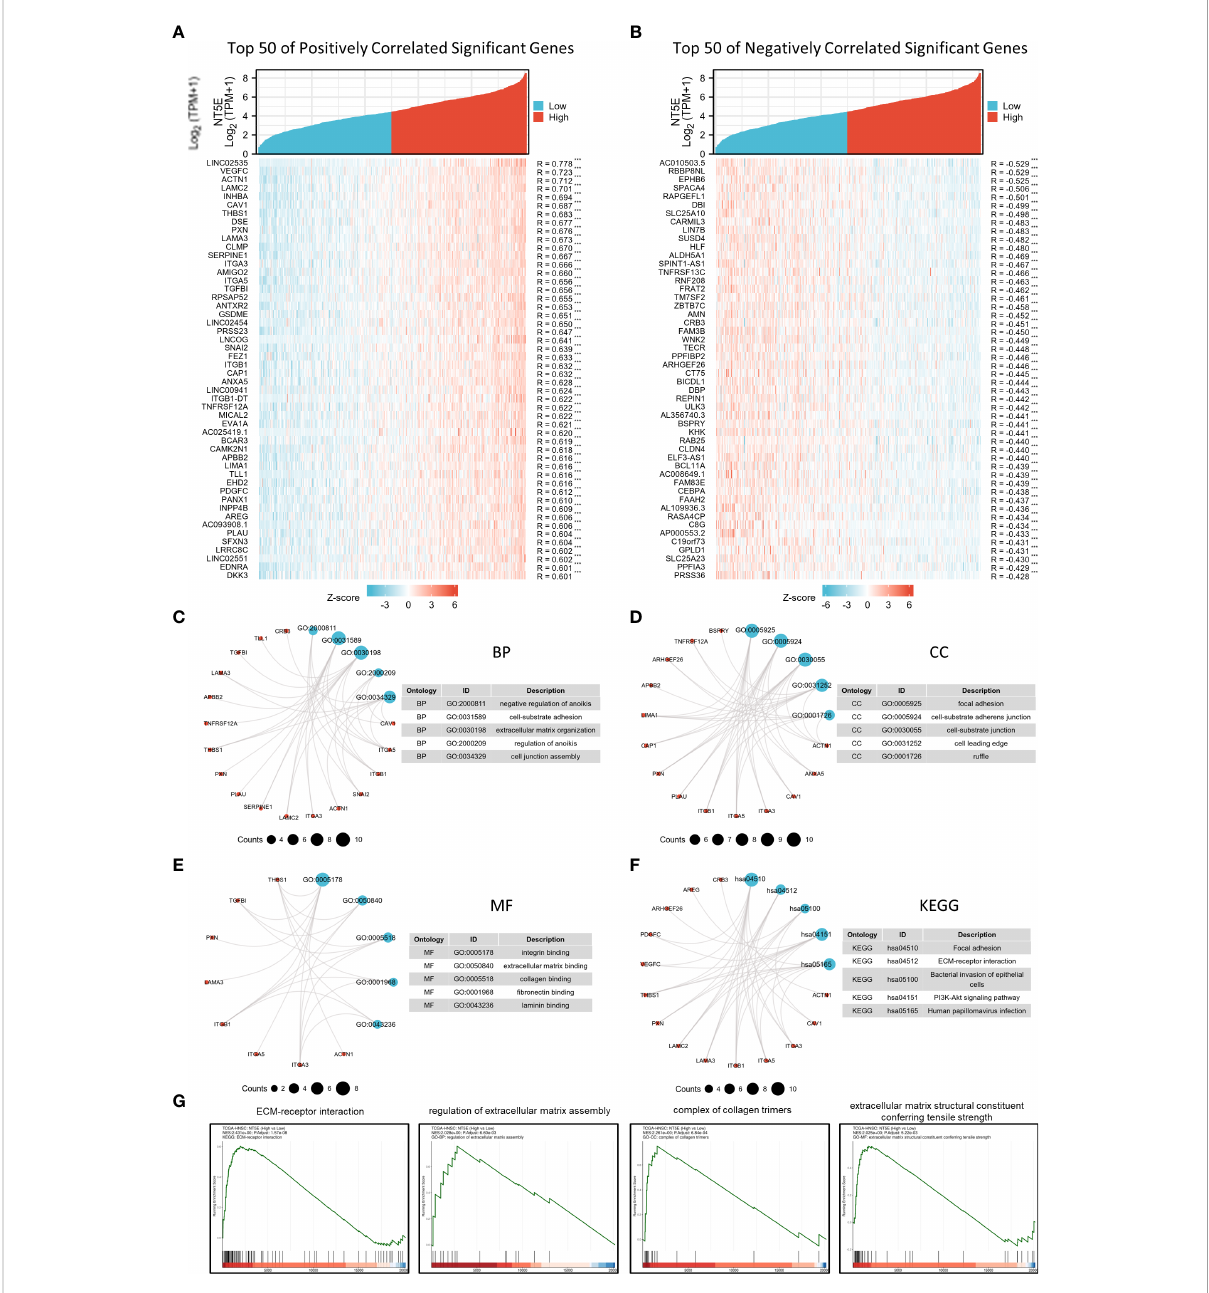
FIGURE 3 Potential biological function of NT5E in HNSC. (A) The top 50 genes positively correlate with NT5E in HNSC (Spearman ’ s correlation analysis, *** p < 0.001). (B) The top 50 genes negatively correlate with NT5E in HNSC (Spearman ’ s correlation analysis, *** p < 0.001). (C) Top 5 BP analyses of NT5E correlated genes in HNSC. (D) Top 5 BP CC analyses of NT5E correlated genes in HNSC. (E) Top 5 BP MF analyses of NT5E correlated genes in HNSC. (F) Top 5 BP KEGG analyses of NT5E correlated genes in HNSC. (G) GSEA analyses of NT5E in